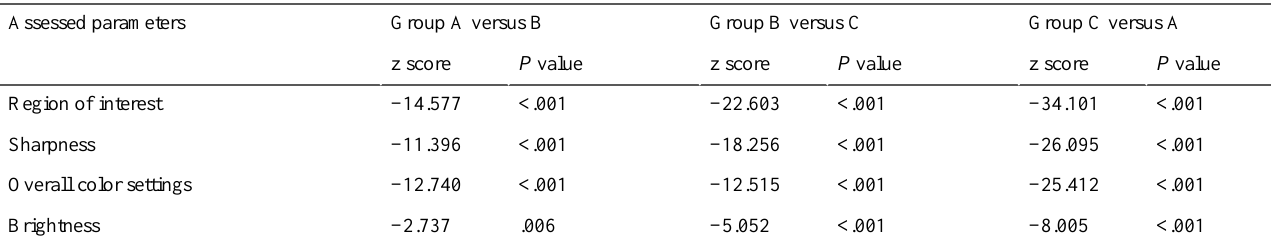
Table 4. Unpaired rank sum, 2-sided Mann-Whitney U (Cronbach alpha=.05) for ratings of the images of the 3 groups taken with Google Glass.